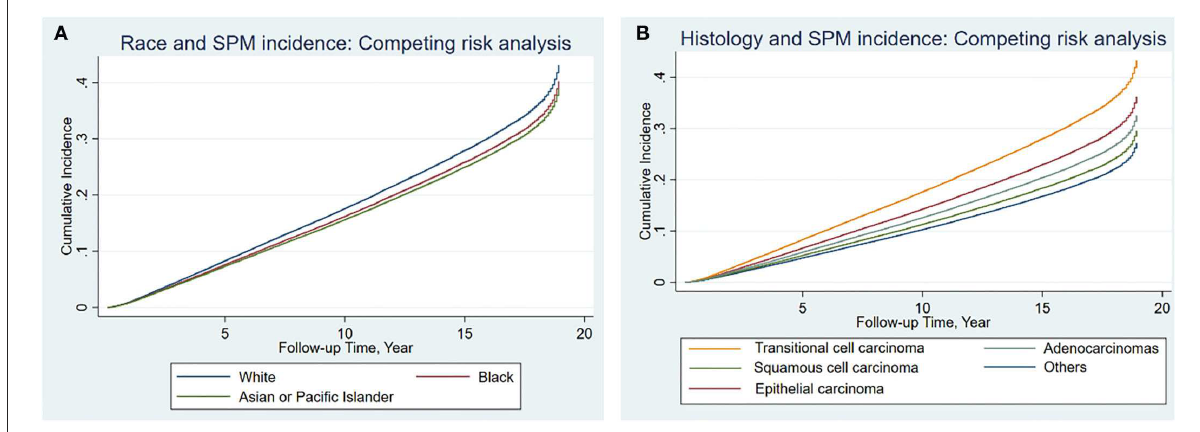
FIGURE2 Cumulative incidence of second primary malignancies among the different races (A) and histological variants (B) in bladder cancer based on the Fine-Gray method.